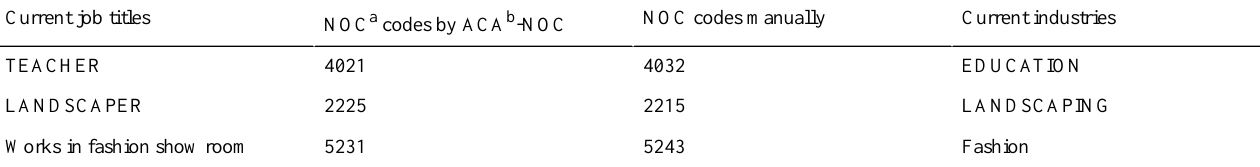
Table 10. Unmatched data for Generation